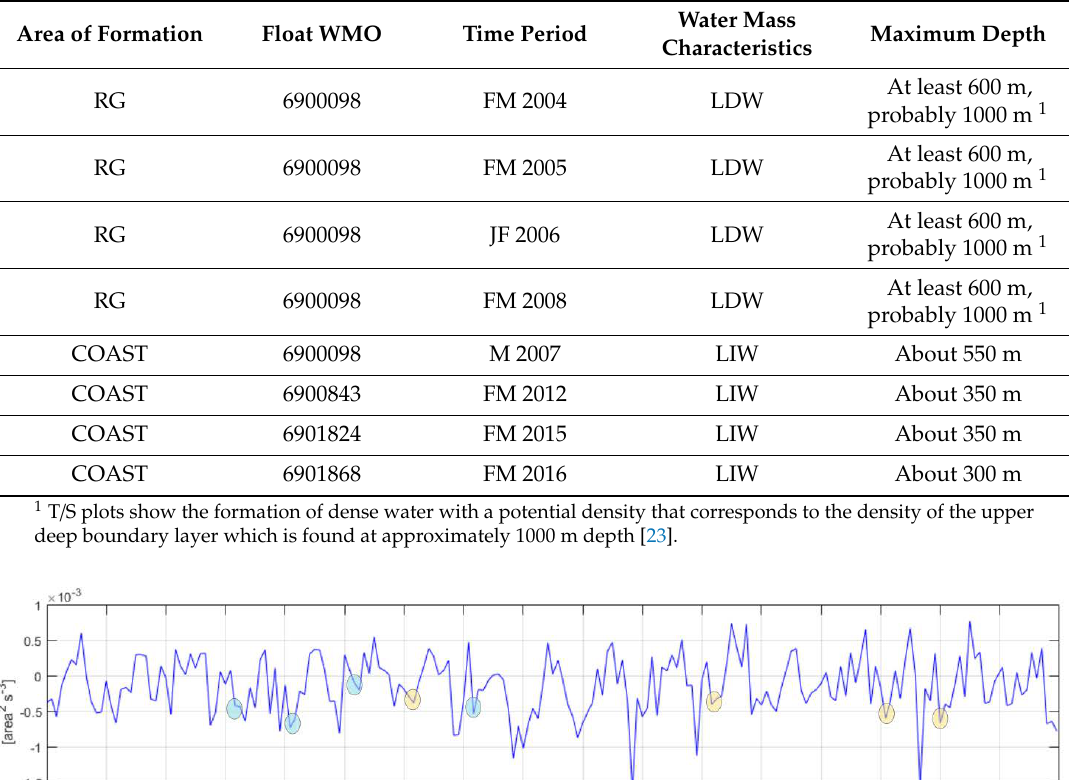
Table 1. Pronounced (mixed layer depth (MLD) > 250 m) dense water formation events within the center of RG and along the Northern coastline: Area of formation, float WMO, time period, watermass characteristics, and maximum depth during the dense water formation events.